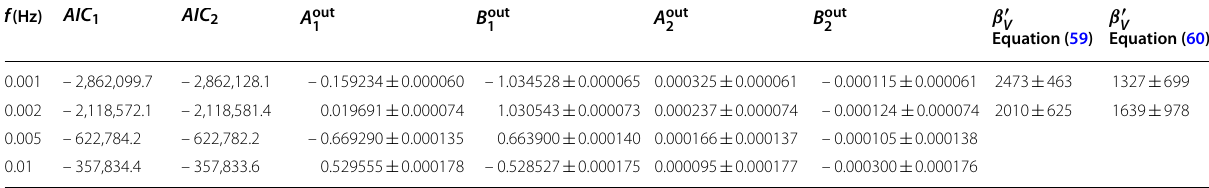
Table 2 Measurement results for the four lowest